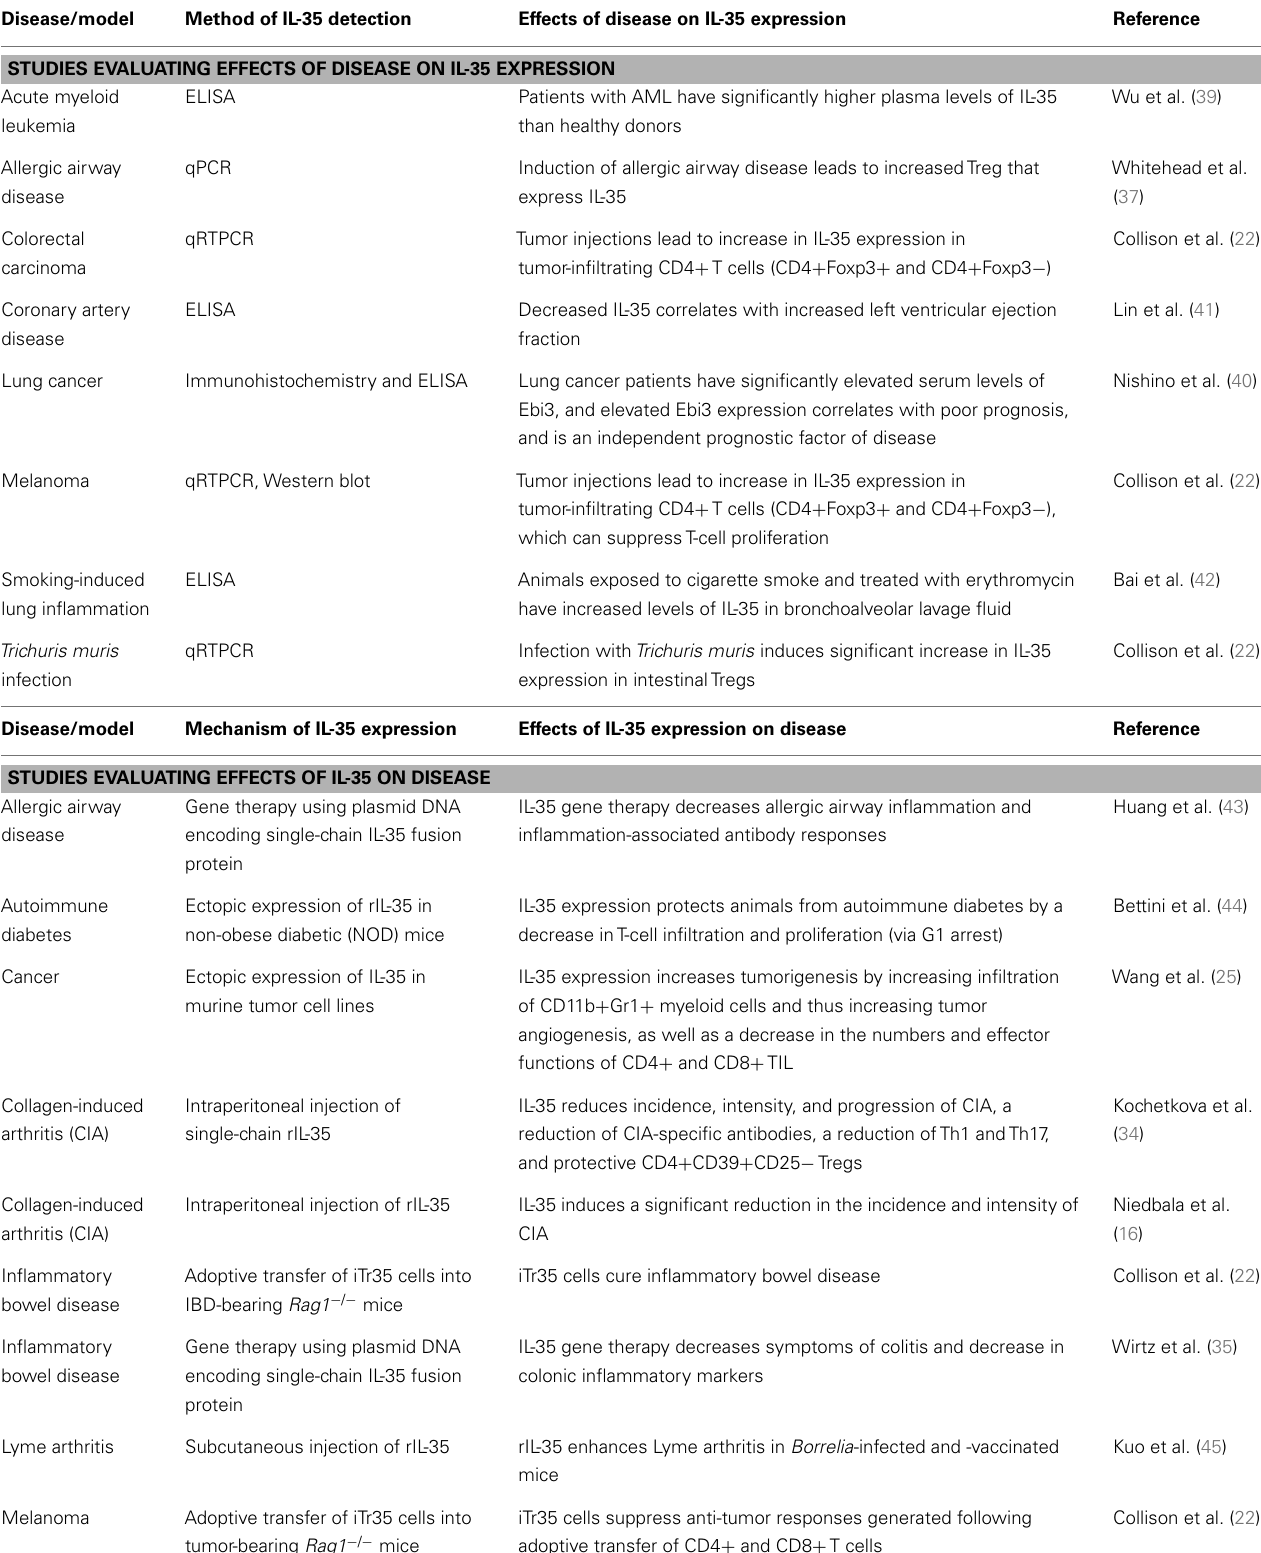
Table 1 | Role of IL-35 on